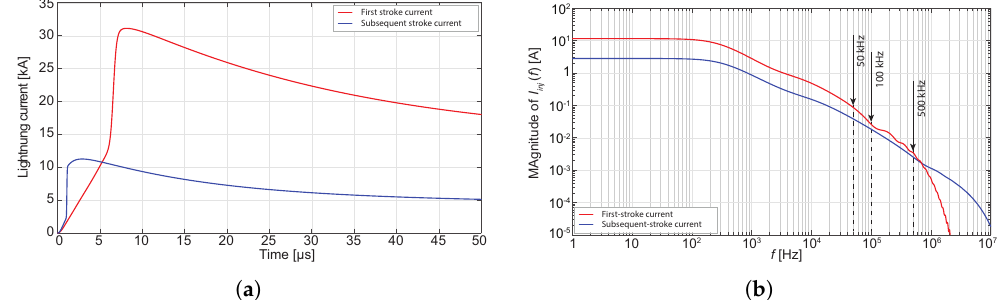
Figure 20. First and subsequent stroke currents injected at the top of the studied towers. ( a ) First [97] and subsequent [98] stroke currents in the time domain. ( b ) Frequency spectrum (magnitude) of the lightning currents in ( a ).